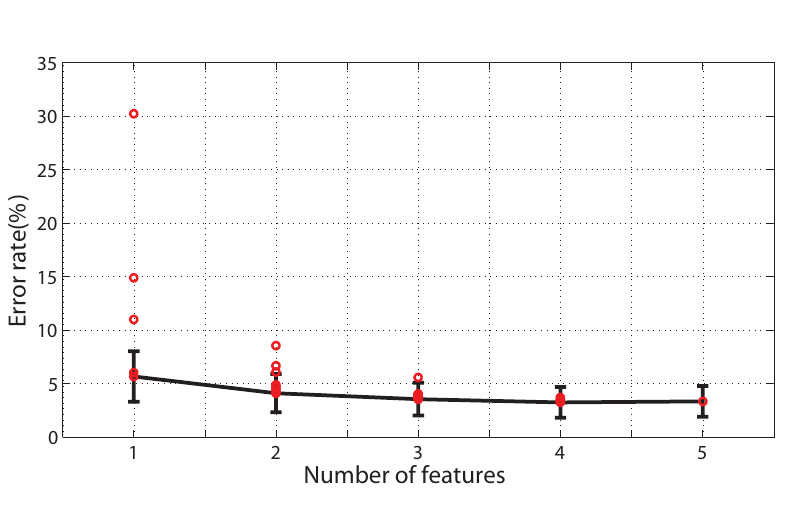
Figure 5. Classification errors of different combinations and numbers of features. The red dots represent the average classification errors of all the subjects in a specific number of features. The lowest error rate among the combinations is denoted as the black line. The error bar is the standard deviations of the subjects. The results are obtained by the LDA classifier with a 200-ms window size. These data were obtained from 12 able-bodied subjects.